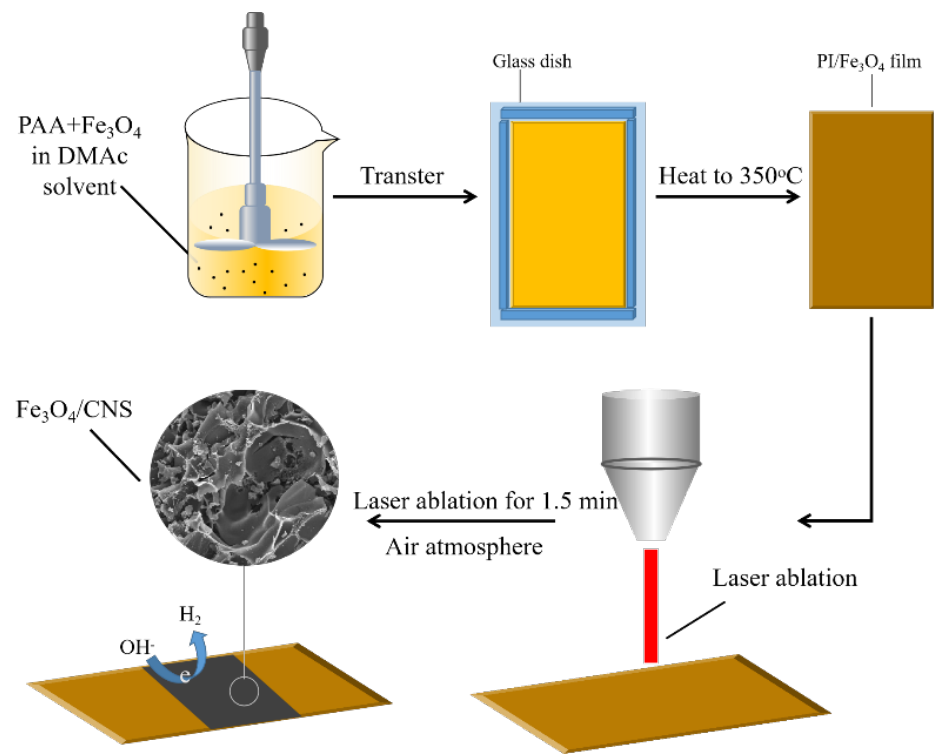
Figure 11. Schematic diagram of the fabrication process of the Fe 3 O 4 /CNS nanocomposite film electrodes by laser shock.